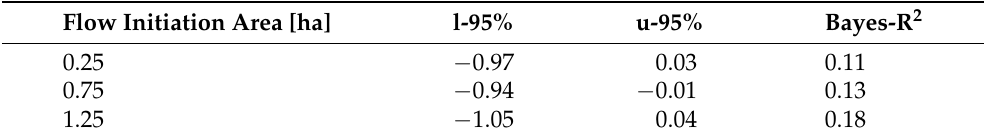
Figure 5. Depth-to-water maps calculated with different flow initiation areas (( A ) 0.25 ha, ( B ) 0.75 ha, ( C ) 1.25 ha) within an aspen-dominated forest stand. Table 2. Model fit summary for Bayesian linear mixed effect models (random slope and intercept across stands) that predicted soil moisture from depth-to-water maps with different flow initiation areas. 95% credible intervals for the effect of depth-to-water are shown, along with Bayes-R 2 as a goodness-of-fit